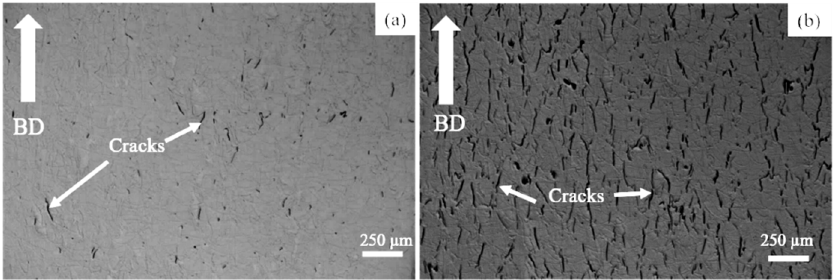
Figure 1. Optical micrographs of as-built ( a ) Hastelloy-X alloys with 0 (HX) and ( b ) and 0.12 (HX-a) yttrium specimens.